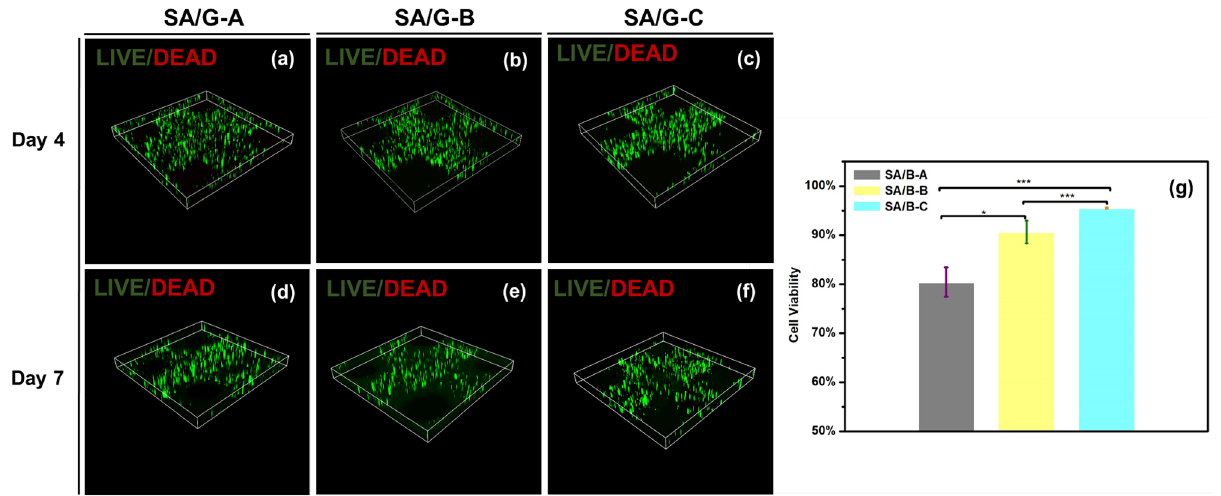
Figure 6. C ytocompatibility of bioprinted semi-IPN bio-ink. ( a – f ) A 3D view of the LIVE/DEAD staining on day4 and day7 after printing. ( g ) Cell viability on the day 1 after printing. All data are displayed as mean ± SD.